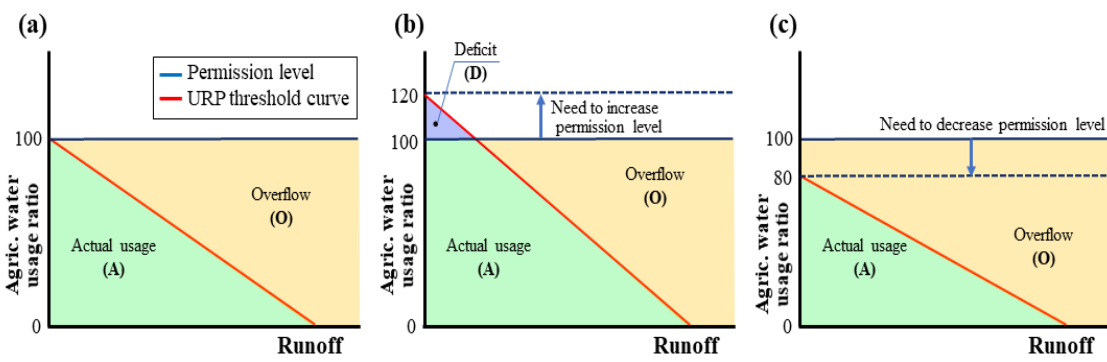
Figure 9. Three types of the URP threshold curve; ( a ) maximum value of the URP curve are equal with permission amount, ( b ) maximum value of the URP curve are larger than permission amount, ( c ) maximum value of the URP curve are smaller than permission amount; blue dot-line in ( b , c ) are the permission amount that need to increase or